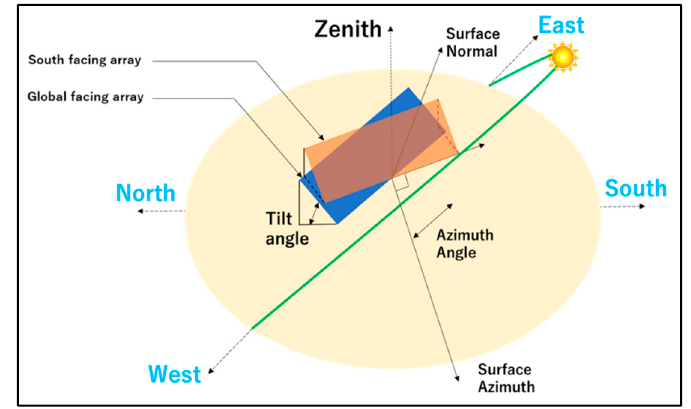
Figure 2. Relationship between sun path and solar panel.